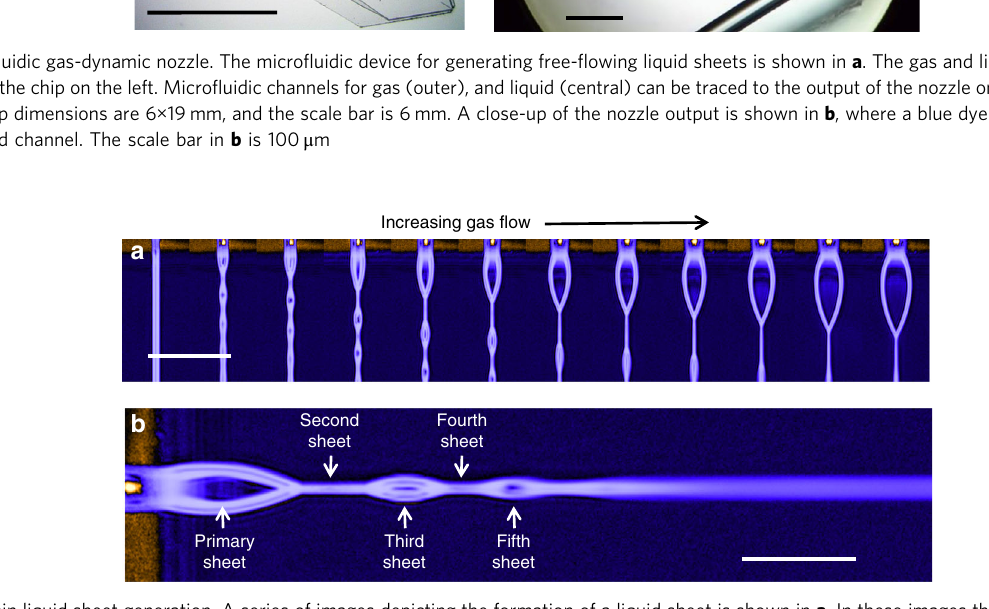
Fig. 2 Ultrathin liquid sheet generation. A series of images depicting the formation of a liquid sheet is shown in a . In these images the nozzle output is on the top, the liquid is fl owing downward, and the gas fl ow increases as we move to the right of the fi gure. The cylindrical liquid jet on the far left evolves into a thin sheet as gas fl ow is increased. The scale bar in a is 1 mm. A more detailed view of the alternating orthogonal sheet structure is shown in b , where the nozzle is on the left, and the liquid is fl owing to the right. The scale bar in b is 500 μ